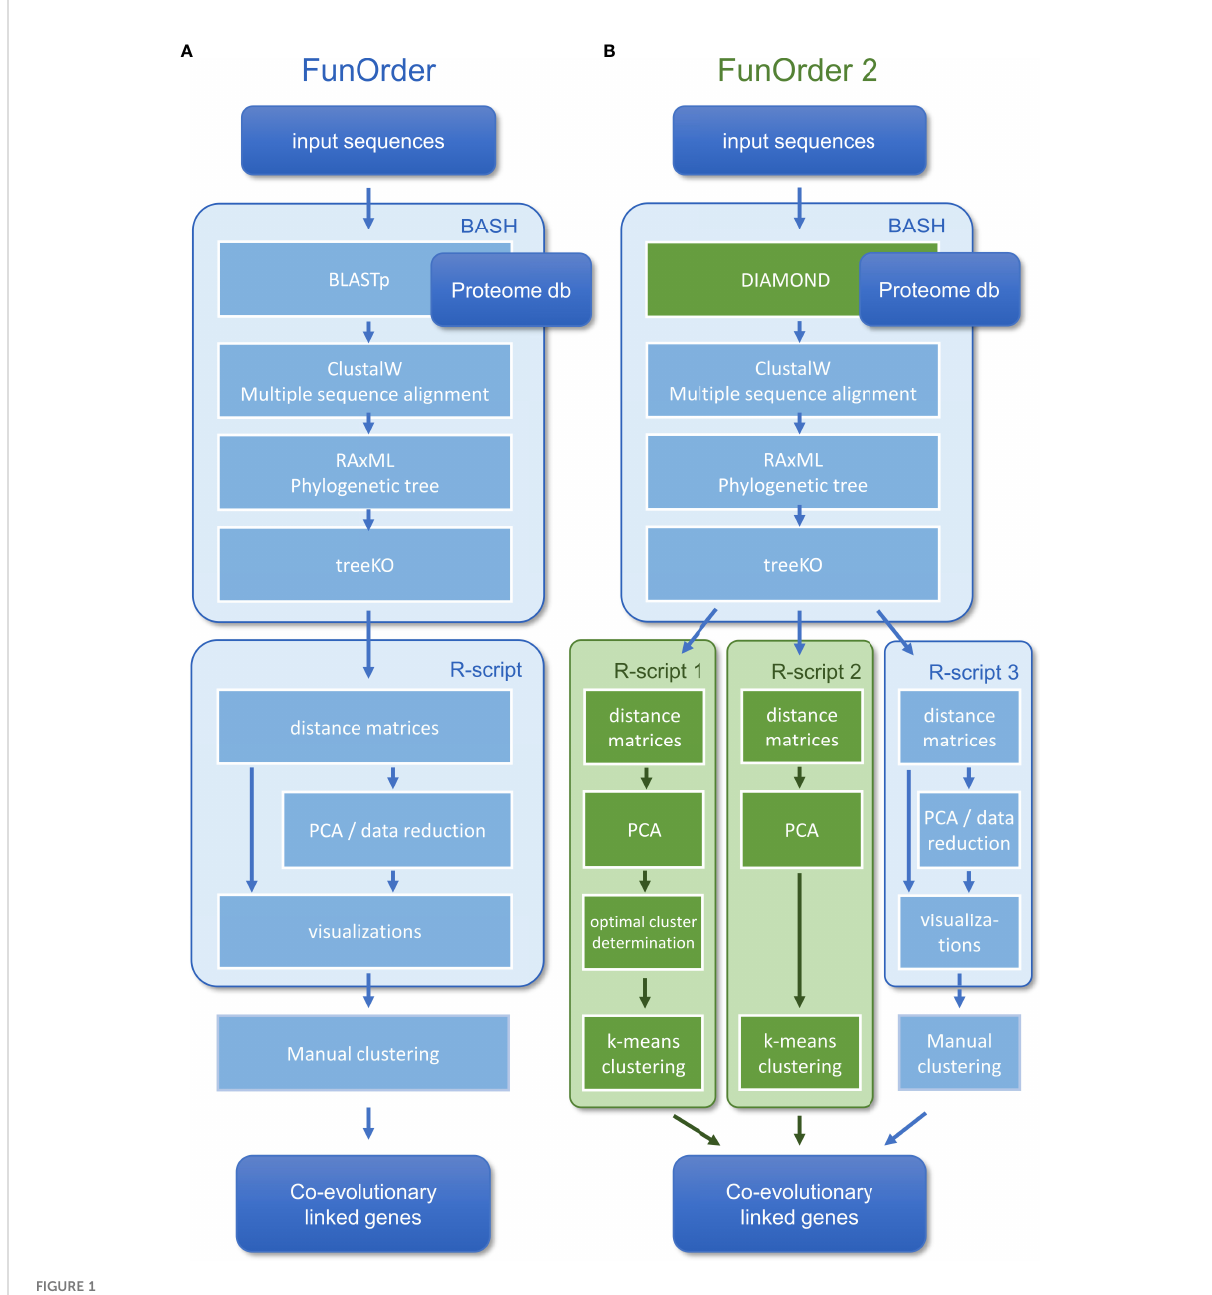
FIGURE 1 Comparison of the work fl ow of the original FunOrder method (A) and FunOrder 2.0 (B)